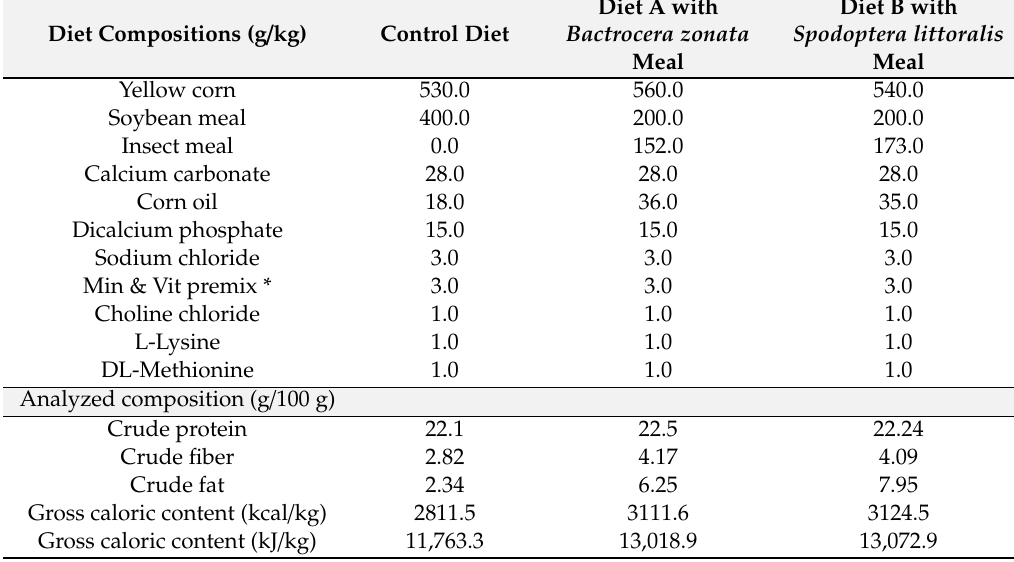
Table 1. Ingredients and composition of experimental